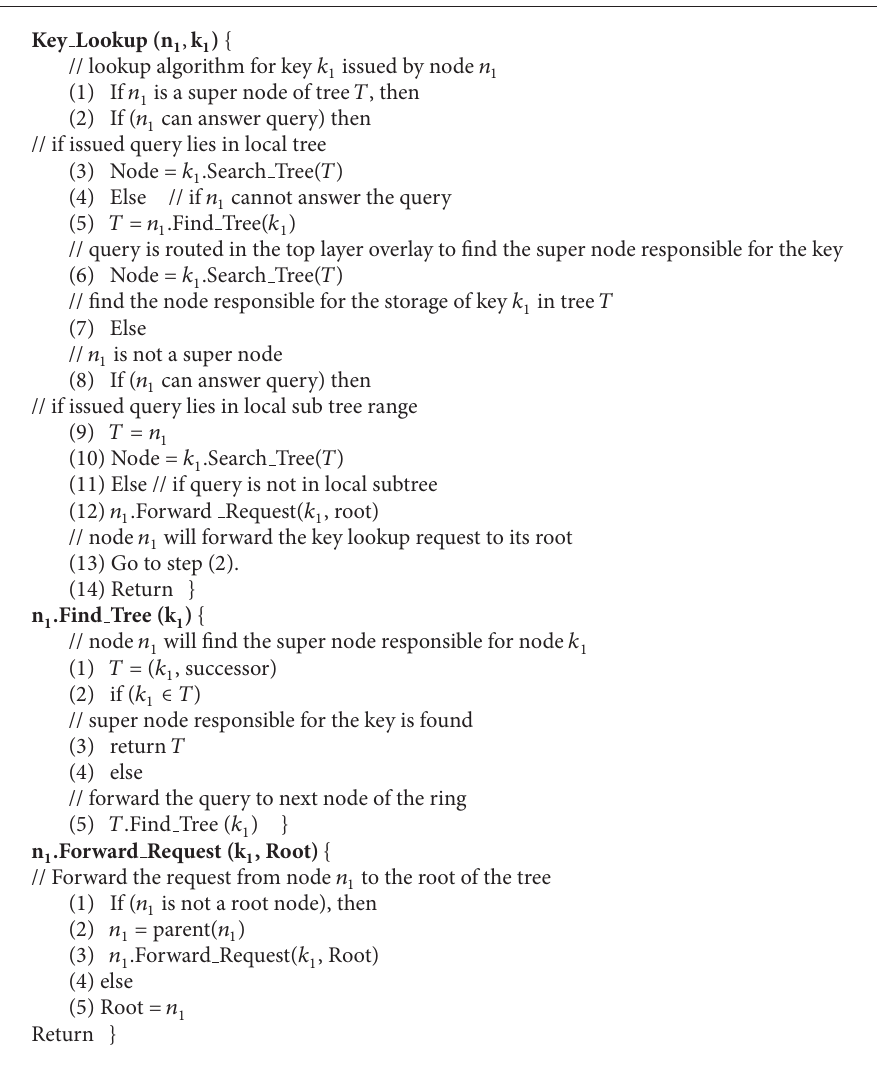
Algorithm 5: Key lookup operation in proposed architecture.